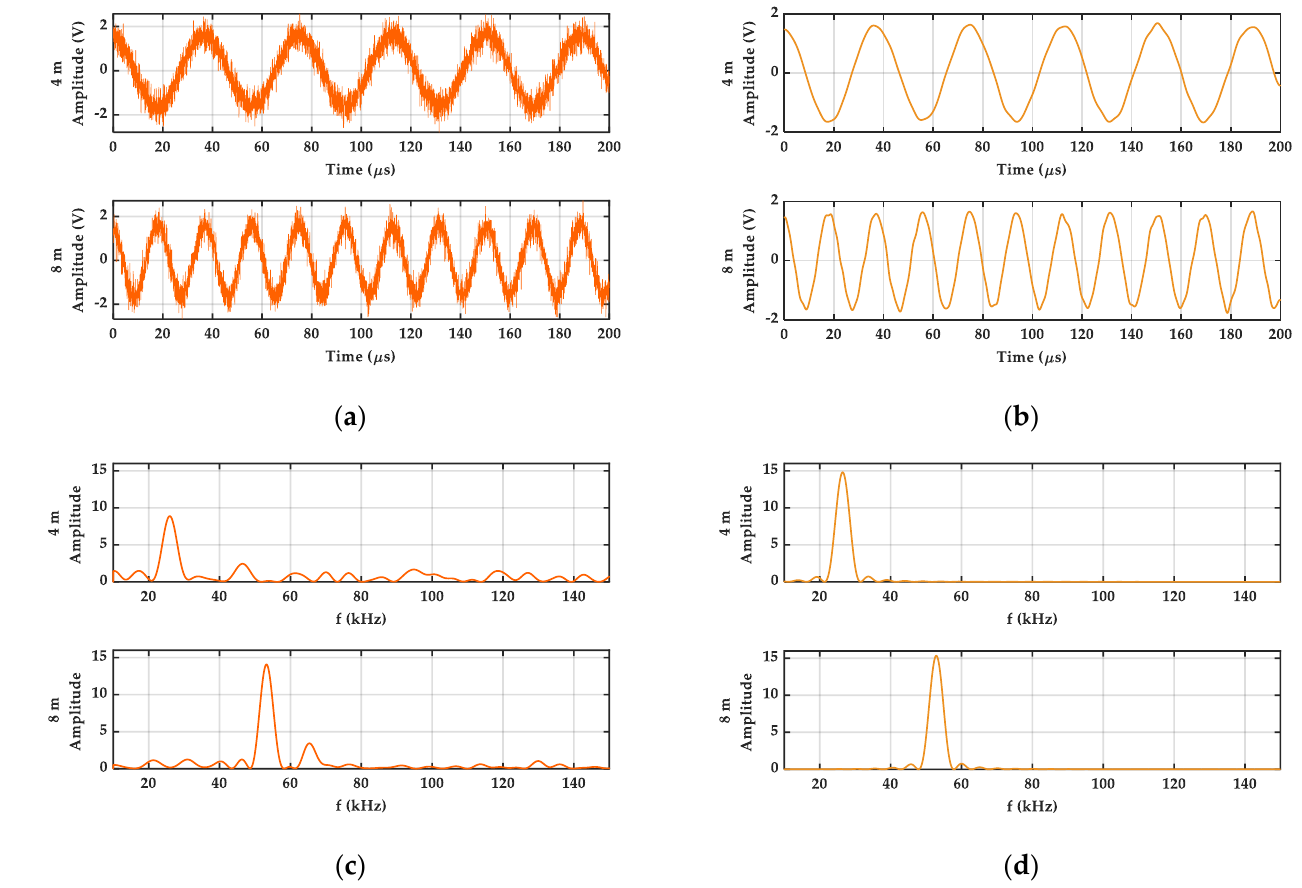
() s n obtained by original B s n . ( c ) The power spectrum of ( ) s n . ( d ) B B